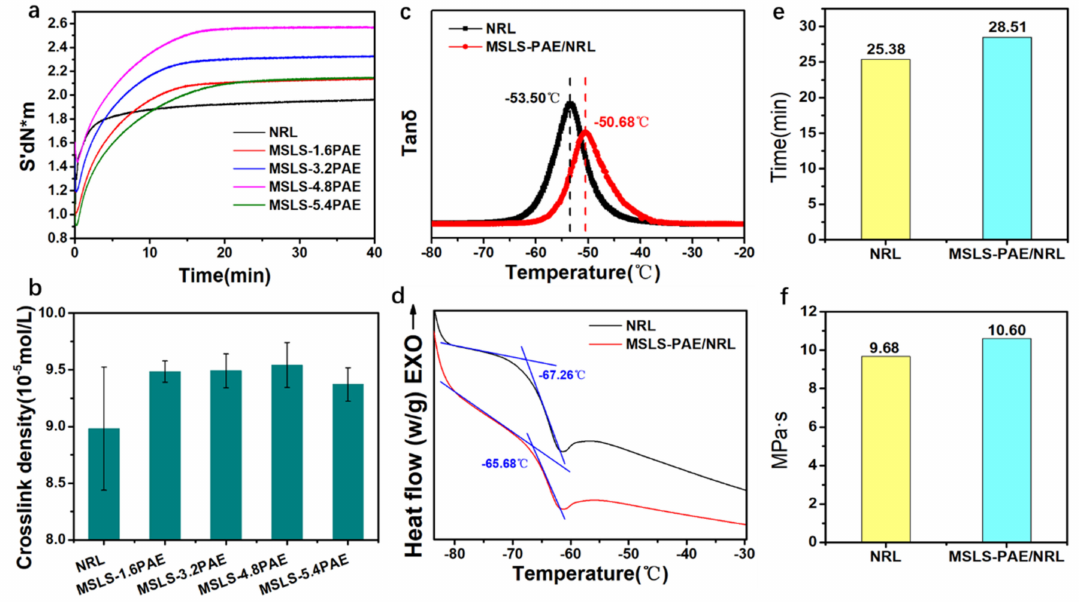
Figure 4. ( a ) Vulcanization characteristic curve, ( b ) crosslink density of natural rubber latex with different PAE content, ( c ) DMA and ( d ) DSC curves of NRL and MSLS-PAE/NRL, ( e ) mechanical stabilization time, and ( f ) viscosity of NRL and